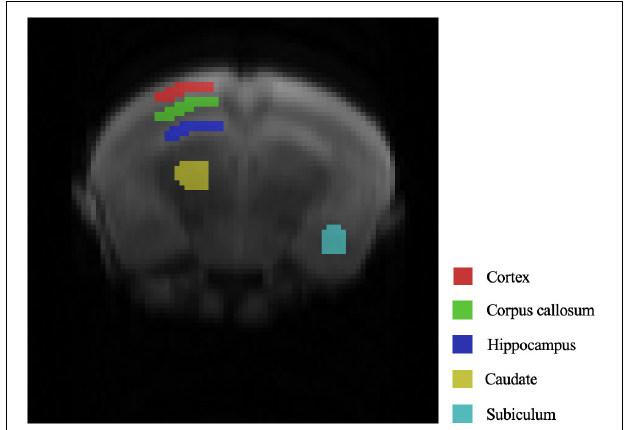
FIGURE 1 | Selected ROIs in the mouse